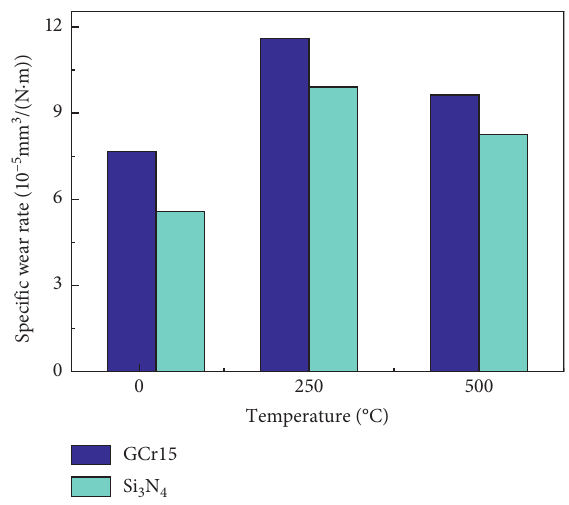
Figure 6: Effects of testing temperature on the specific wear rate of Inconel 625 superalloy at a sliding rate of